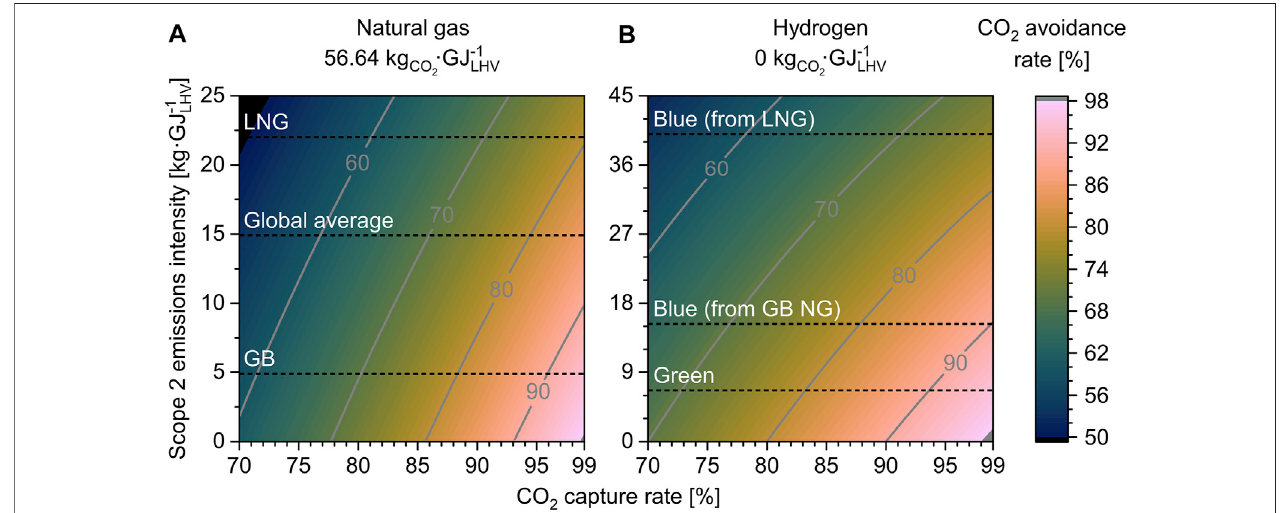
FIGURE 2 | Interplay between CO 2 avoidance rate (color map and contour lines), CO 2 capture rate ( x -axis), and scope 2 emissions intensity ( y -axis) in post- combustion CCS. (A) : Scenario of a CCS unit powered by a natural gas- fi red CHP plant, with all its exhaust gases directed to the CCS unit. The dashed horizontal line labelled GB indicates natural gas from Great Britain; those labelled Global average and LNG depict natural gas and lique fi ed natural gas mix, respectively, at the global average emissions intensity. (B) : Alternative scenario of a CCS unit powered by a hydrogen- fi red CHP plant. The two dashed lines labelled Blue correspond to hydrogen produced via steam reformingofnatural gasfrom Great Britain or LNG at theglobalaverage emissions intensity, both assuming a90% CO 2 capture ratefrom the reformer fl ue gas; the line labelled Green considers water electrolysis powered by wind electricity. Refer to Section 3 of the ESI for details about the underlying assumptions and the calculation